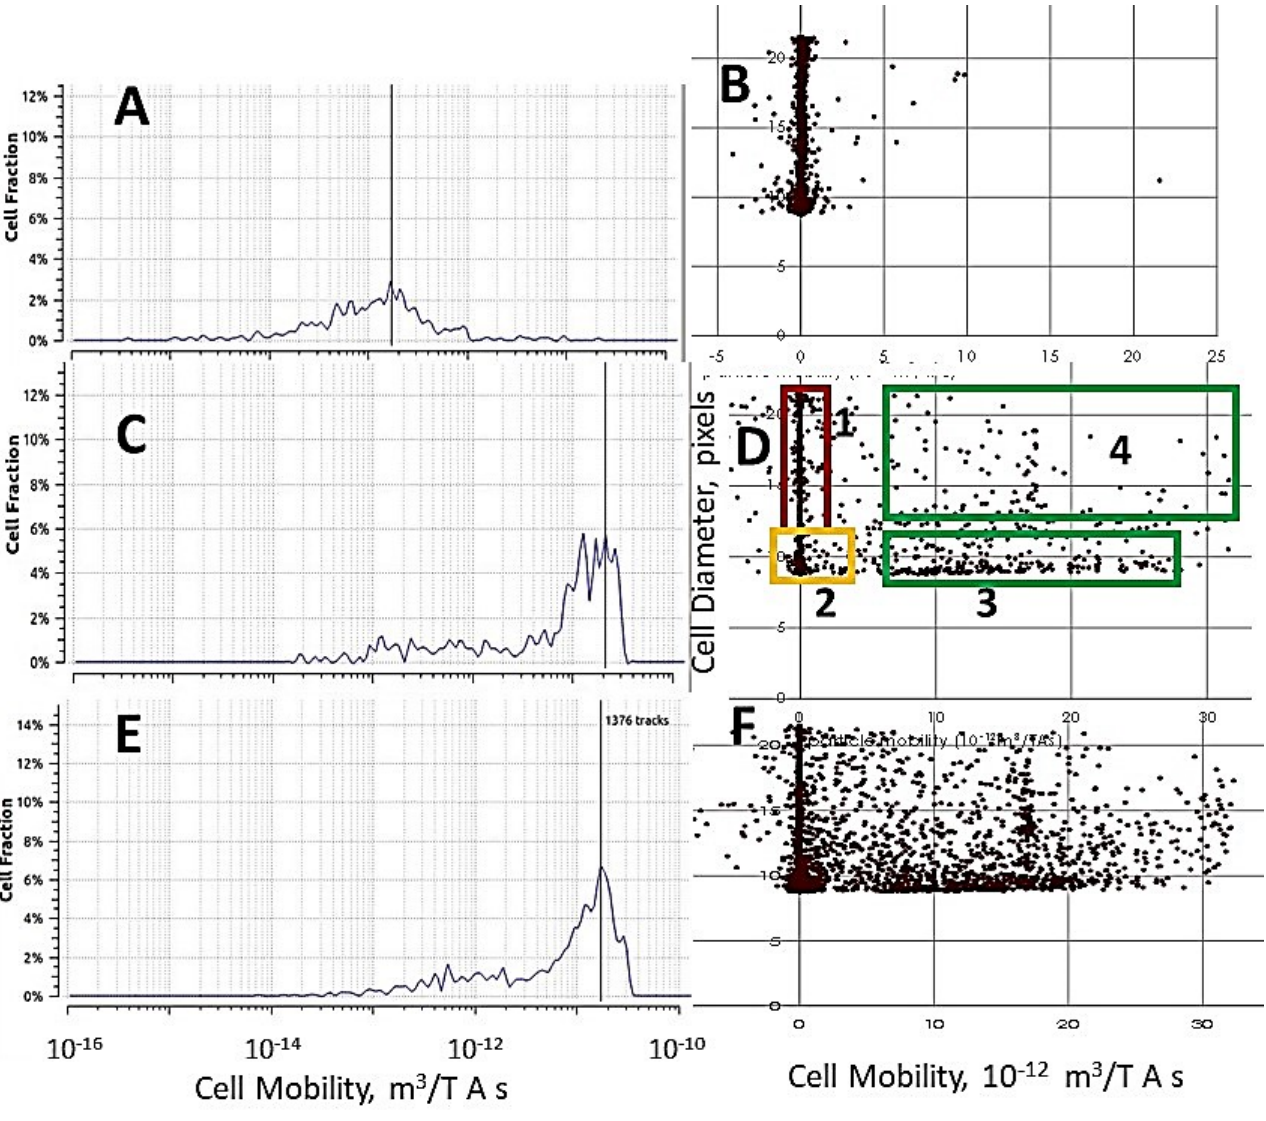
Figure 8. Magnetic analysis of cells collected in the trap after labeling by standard shake table method and by in-line mixing affirming the results of Figure 4 (complete mixing). ( A ): Magnetophoretic mobility histogram of unlabeled CRL-211, DT40 chicken lymphoma cells showing a typical broad distribution for unlabeled cells. ( B ): Two-parameter plot of diameter (in pixels) vs. mobility (linear scale) showing very few objects with non-zero mobility. ( C ): Mobility histogram of cells labeled for 20 min with immunomagnetic Dynabeads on a rocker table. ( D ): Two-parameter plot for labeled cells showing the categories counted: 1 = unlabeled cells (depleted vs. control due to labeling); 2 = debris; 3 = unbound Dynabeads; 4 = magnetically labeled cells. ( E ): Mobility histogram of cells labeled in 10 min with reagent solution and cell suspension flowing through the in-line mixer at 1.0 mL/min. ( F ): Two-parameter plot for labeled cells harvested from the in-line mixer showing abundance of labeled cells with a cluster at mobility = 17 × 10 − 12 m 3 /Tas, as also seen on the histogram (8E).